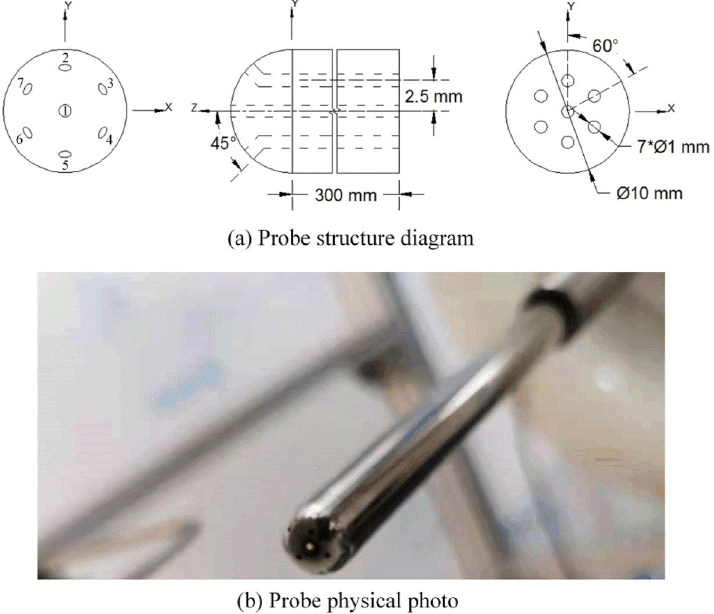
Figure 1. ( a ) Schematic diagram of the 7-hole probe structure, ( b ) physical diagram of the 7-hole probe.